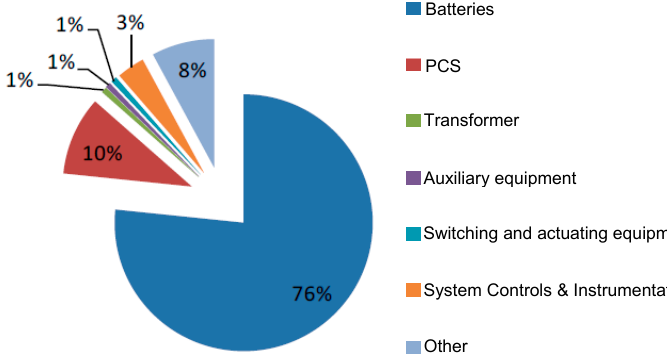
Figure 13. Na-NiCl 2 percentage costs.